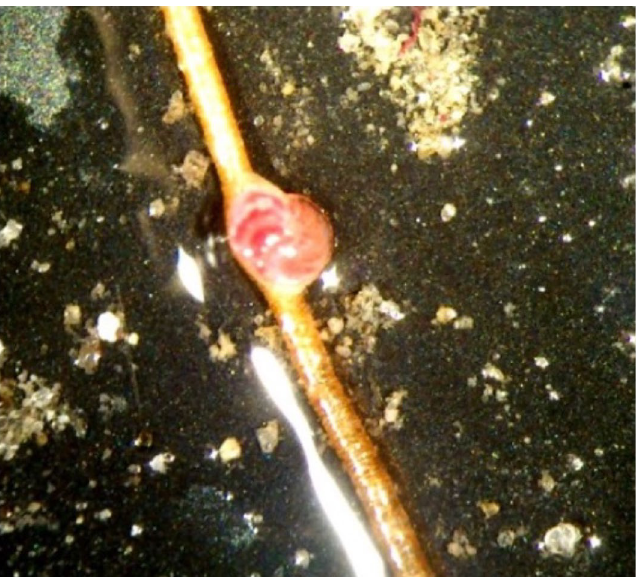
Figure 8. Rose Bengal stained Cibicidoides wuellerstorfi attached to a Siboglinidae tube; Siboglinidae field MUC 10A. Photo: K.